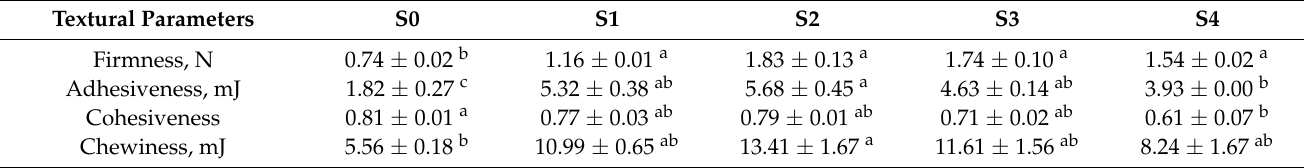
Table 4. Texture profile analysis of mayonnaise samples enriched with different levels of